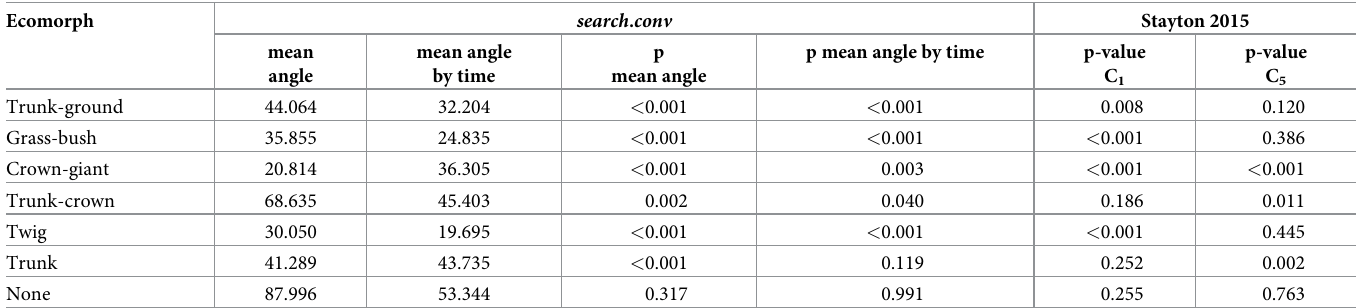
Table 4. Results of convergence within Anolis ecomorphs. The left columns represent the results obtained by applying search . conv . The last two rightmost columns are the corresponding results pertaining to the metrics C1 and C5, retrieved from [22]. mean angle = the mean angle between species within the ecomorph; mean angle by time = the mean angle between species within the ecomorph divided by time distance; p mean angle = significance level for mean angle; p mean angle by time = significance level for mean angle by time; p-value C1 = significance level for the C1 measure [22]; p-value C5 = significance level for the C5 measure [22]. Ecomorph search . conv Stayton